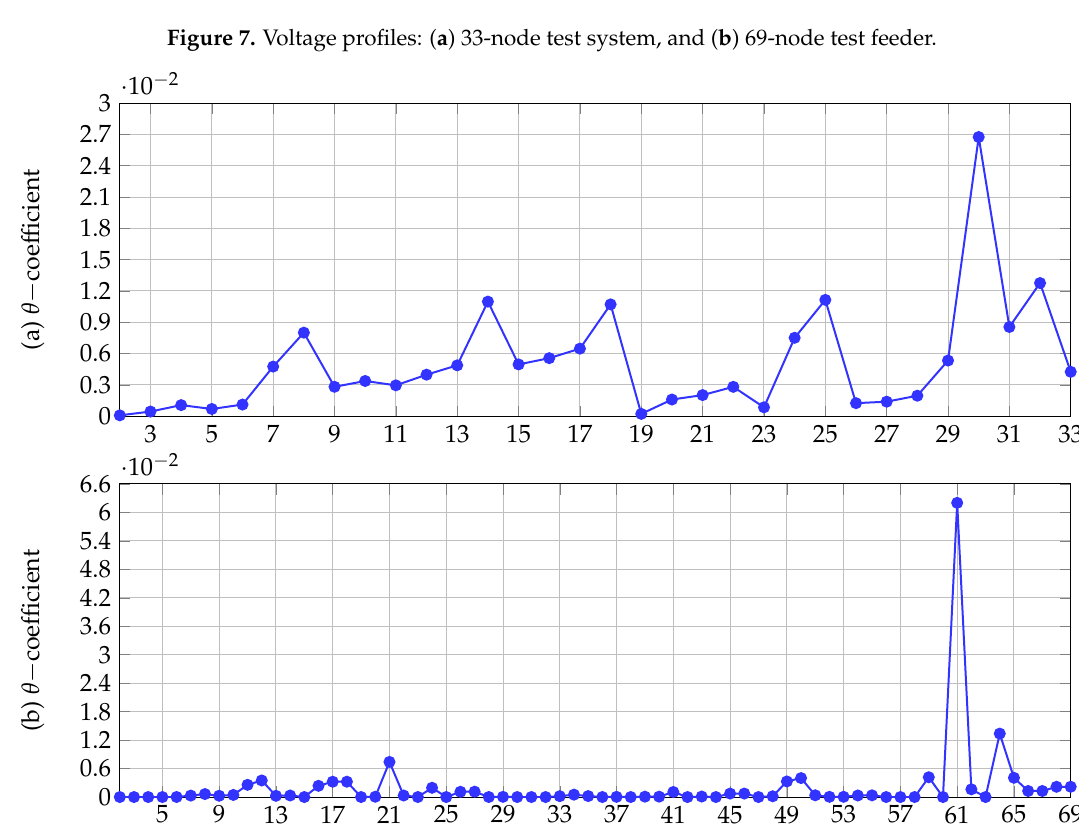
Figure 8. Behavior of the θ -coefficient: ( a ) 33-node test system, and ( b ) 69-node test